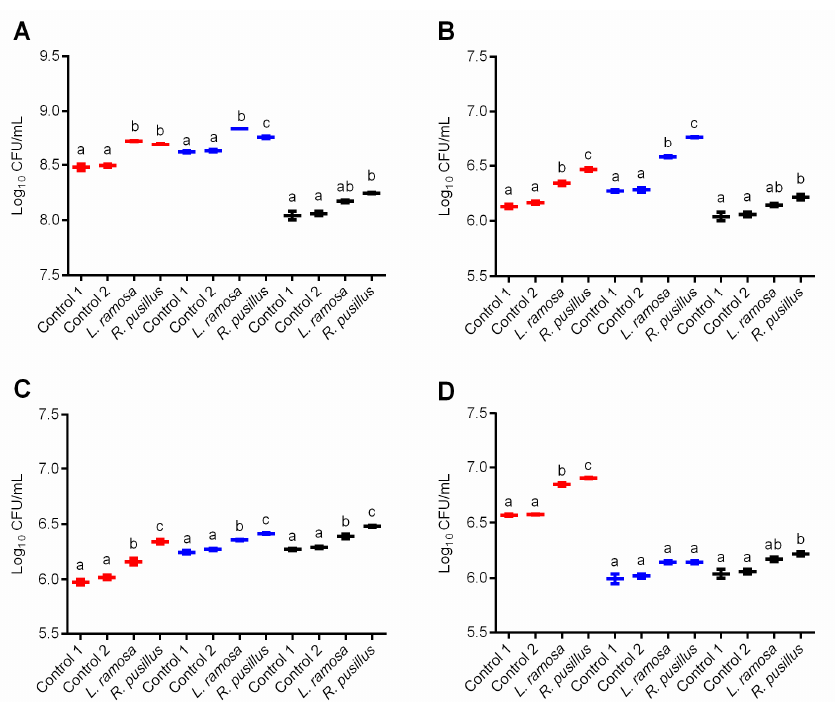
Figure 5. Effect of oligosaccharide-enriched solutions on the growth of L. casei ( A ), L. acidophilus LA-5 ( B ), B. animalis subsp. lactis BB-12 ( C ) and S. boulardii CNCM I-745 ( D ) probiotic microorganisms. Solutions were produced with L. ramosa and R. pusillus partially purified β -galactosidase-active cocktails on lactose-fructose (red), skim milk (blue) or lactose (black) initial sugar substrates. The colony number counted in the absence of the given solution was taken as Control 1, while Control 2 contained the enzyme-free sample of the corresponding reaction mixture. Presented results are means of three replicates; error bars represent standard deviations. Different letters indicate statistical differences between the controls and the corresponding treatments ( p < 0.05). Table 3. Correlation coefficients (Pearson r ) between growth-promoting activity towards different probiotics and total tri- or tetrasaccharide content achieved on each initial material after enzymatic treatments with crude β -galactosidase cocktails. Initial Materials L. casei L. acidophilus B. animalis subsp. lactis S.